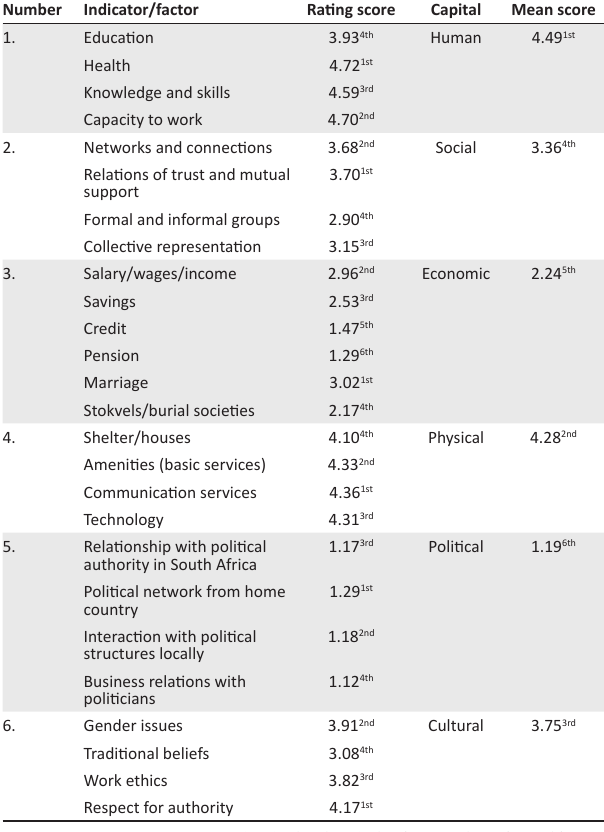
TABLE 9: Capital factors helping women migrants to cope and adapt in South